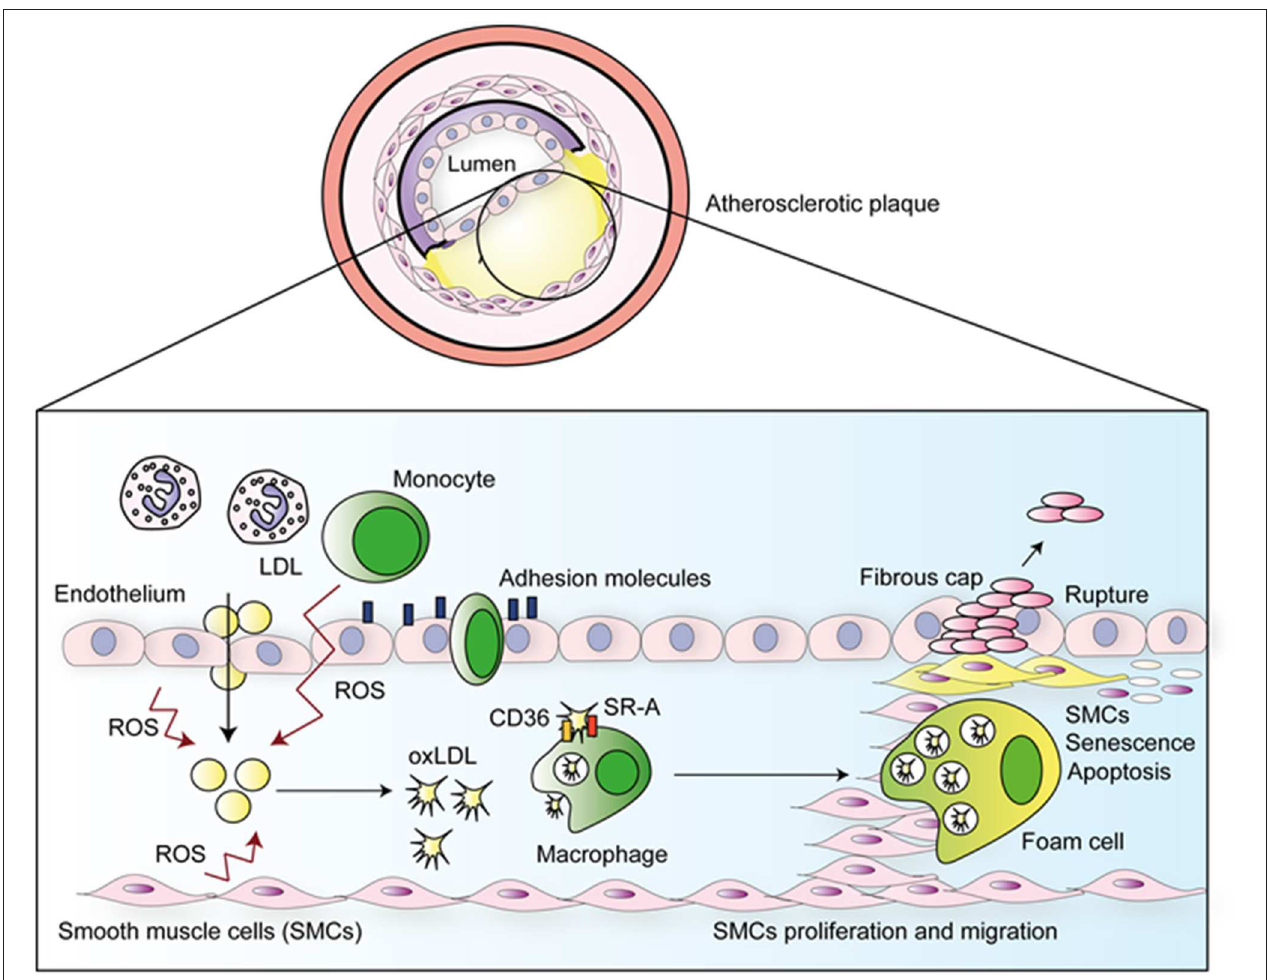
FIGURE 1 | Atherosclerotic disease progression. ROS produced by ECs, SMCs, neutrophils, and macrophages oxidized LDL in the sub-endothelial space. Emigrated monocytes become macrophages which uptake oxLDL, subsequently forming foam cells, that are unable to migrate to arterial lumen, accumulate in the sub-endothelial space and die forming a large plaque with a necrotic core. Rupture of this plaque leads to thrombus formation.